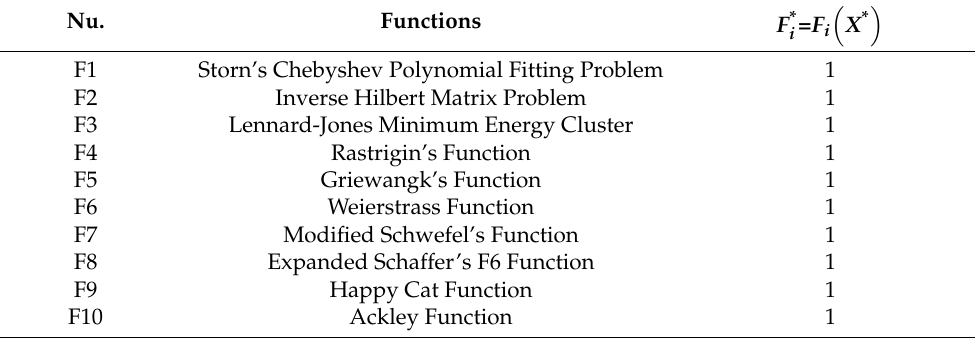
Table 9. CEC 2014 test functions. Nu.